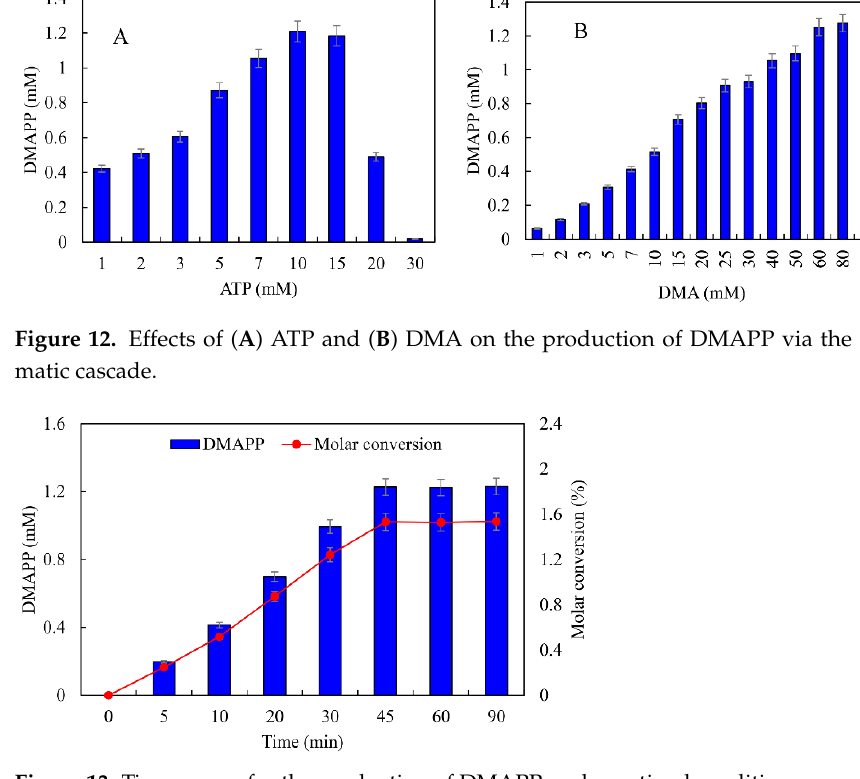
Figure 13. Time course for the production of DMAPP under optimal conditions.